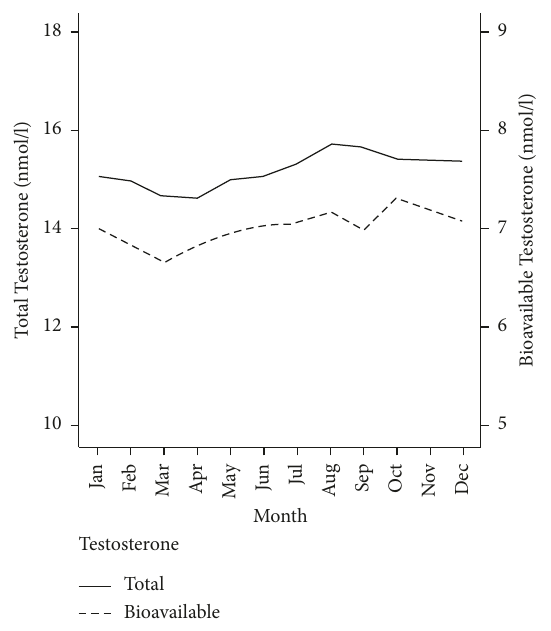
Figure 1: Monthly variations in total and bioavailable testosterone levels in a cohort of men aged 20–70. Table 3: Total and bioavailable testosterone levels determined in different